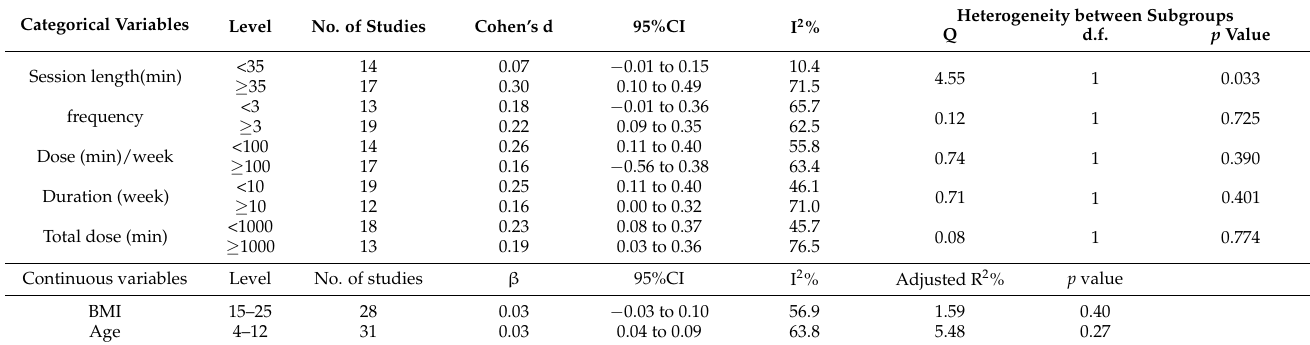
Table 2. Moderator analysis of cognitively engaging PA and